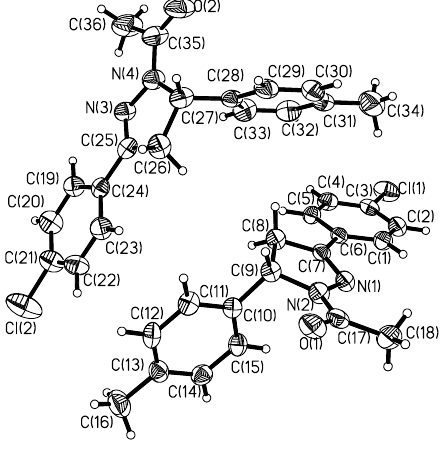
Figure 1. Molecular structure with the atomic numbering scheme for the title